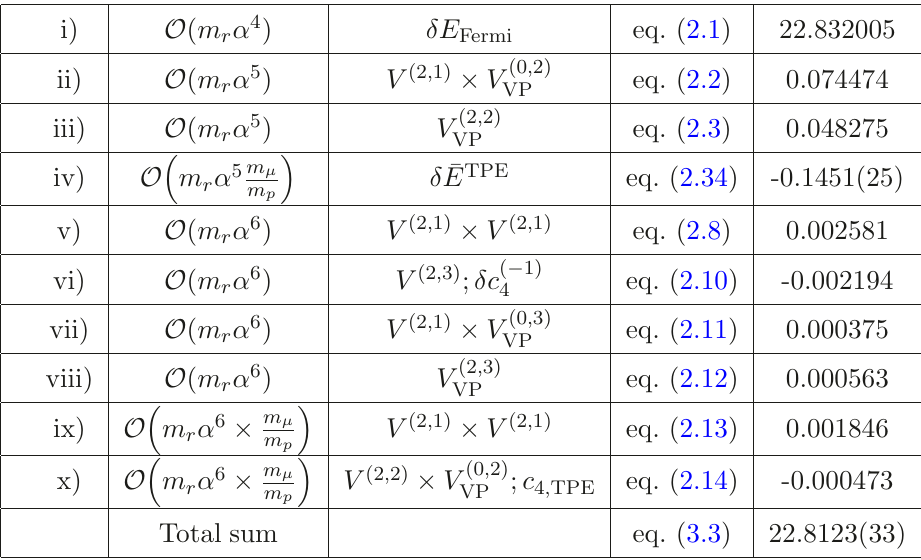
Table 2 . The different contributions to the hyperfine splitting for the 2S in muonic hydrogen in meV units. The value for the iv) and x) entries is obtained from the hydrogen hyperfine